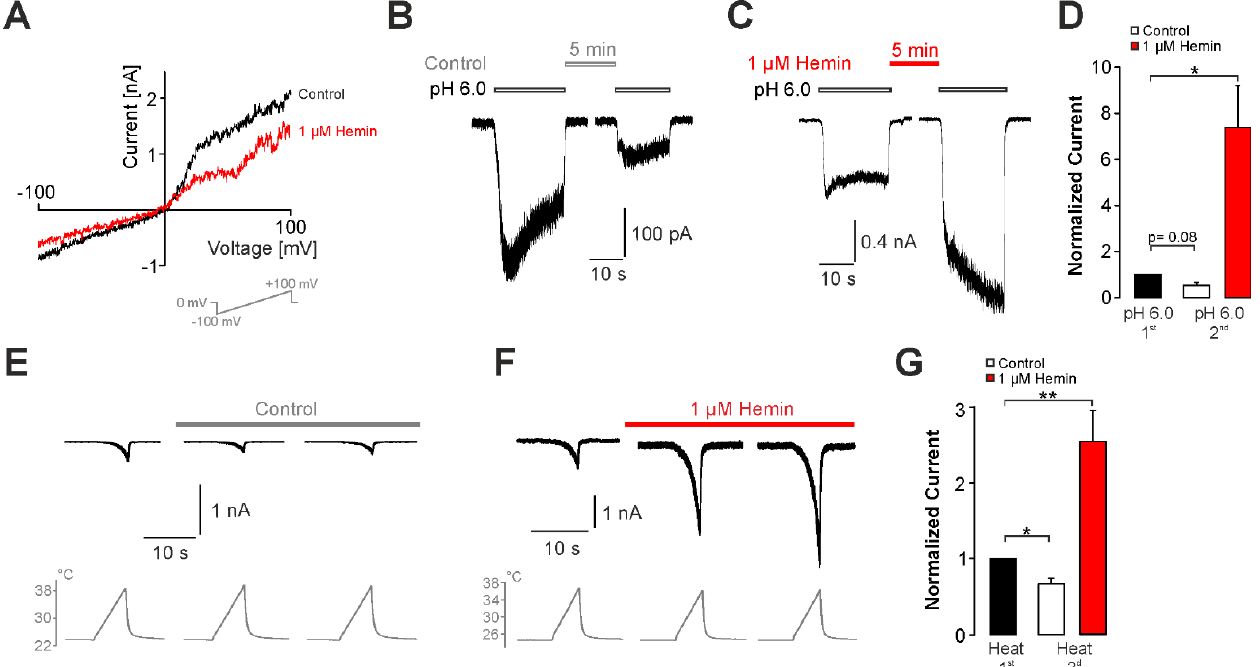
Figure 3. Hemin sensitizes hTRPV1 when examined with patch clamp electrophysiology. ( A ) Representative whole-cell patch clamp recording on a HEK293t cell expressing hTRPV1. Membrane currents were evoked by 500 ms long voltage- ramps from -100 to +100 mV. Note that hemin reduces the membrane current. ( B , C ) Whole-cell patch clamp recordings on hTRPV1-expressing cells challenged with two consecutive applications of pH 6.0 with control solution (B or 1 µM hemin ( C ) applied for 5 min between applications of acidic solution. ( D ) Mean normalized peak amplitudes of inward currents evoked by pH 6.0 in ( B , C ). Current amplitudes were normalized to the amplitude of the first current. ( E , F ) Typical heat-evoked inward currents in cells expressing hTRPV1. Following the first challenge with heat, cells were treated either with control solution ( E ) or hemin ( F ) and the depicted currents were recorded after 3 or 6 min, respectively. ( G ) Mean normalized peak amplitudes of inward currents evoked by heat in ( E , F ). Current amplitudes recorded after 6 min were normalized to the amplitude of the first current. Cells were held at -60 mV in all patch clamp experiments. Data are shown as mean ± S.E.M. * denotes p < 0.05, ** denotes p <